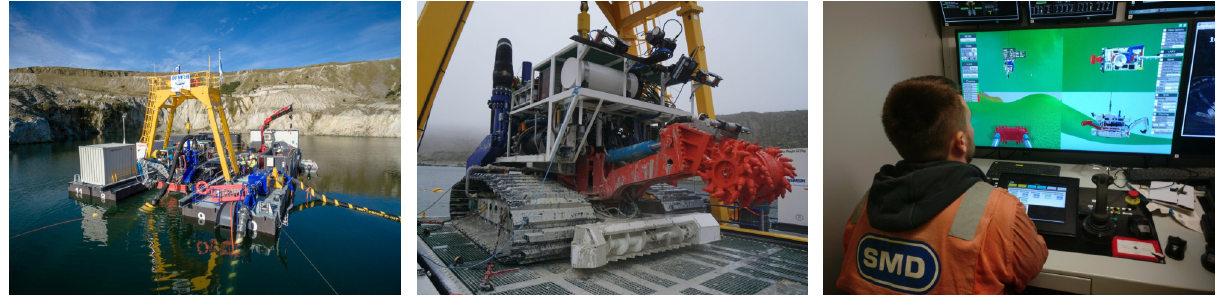
Figure 2. ¡VAMOS! underwater mining system. Left: launch and recovery vessel during deployment of the mining vehicle, middle: ¡VAMOS! mining vehicle with roadheader cutting machine and perception sensors, right: tele-operation of the mining vehicle using the VR based human-machine